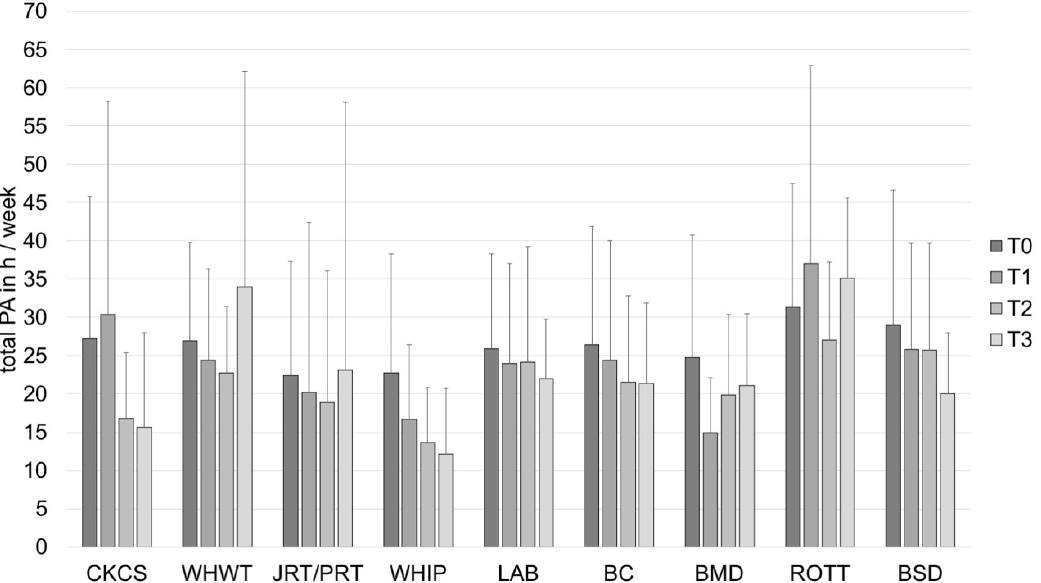
Figure 4. Total PA in h/week (mean ± SD ) of owners of different dog breeds at baseline (T0), after 1 (T1), 2 (T2) and 3 (T3) years. BC, Border Collie; BERN, Bernese Mountain Dog; BSD, Belgian Shepherd Dog; CKCS, Cavalier King Charles Spaniel; JRT/PRT, Jack and Parson Russell Terrier; LAB, Labrador Retriever; PA, physical activity; ROTT, Rottweiler; WHIP, Whippet; WHWT, West Highland White Terrier.